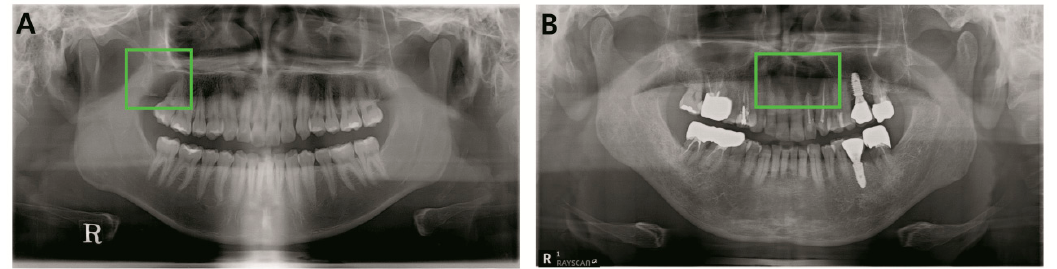
Figure 8. Undetected lesions for both YOLO and clinicians. ( A ). OKC, maxilla right. ( B ). OKC maxilla anterior.